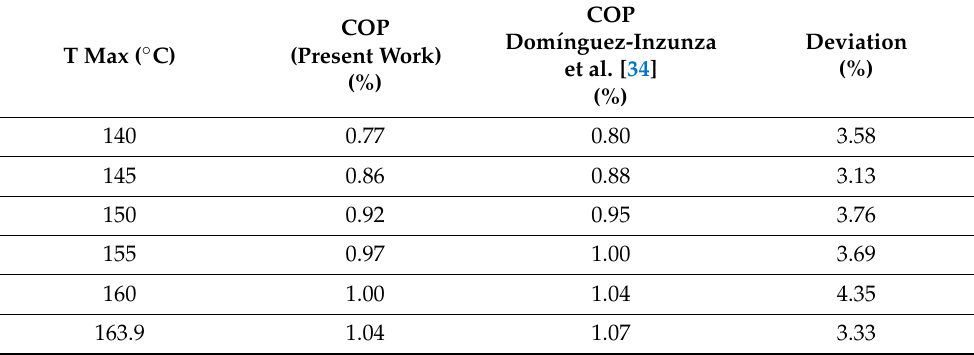
Table 8. Validation of the DEACS model using data from Dom í nguez-Inzunza et al.